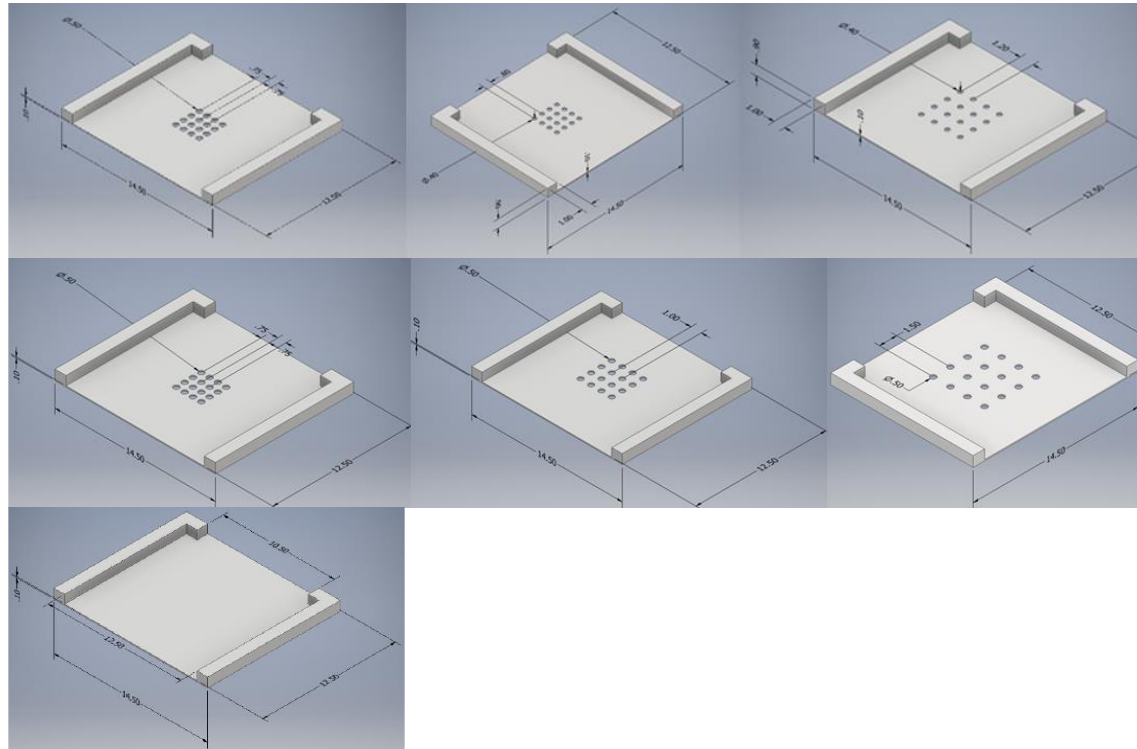
Figure 3: The seven CAD designs to implement the six hybrid surfaces, hydrophilic, and superhydrophobic samples for the experiments.